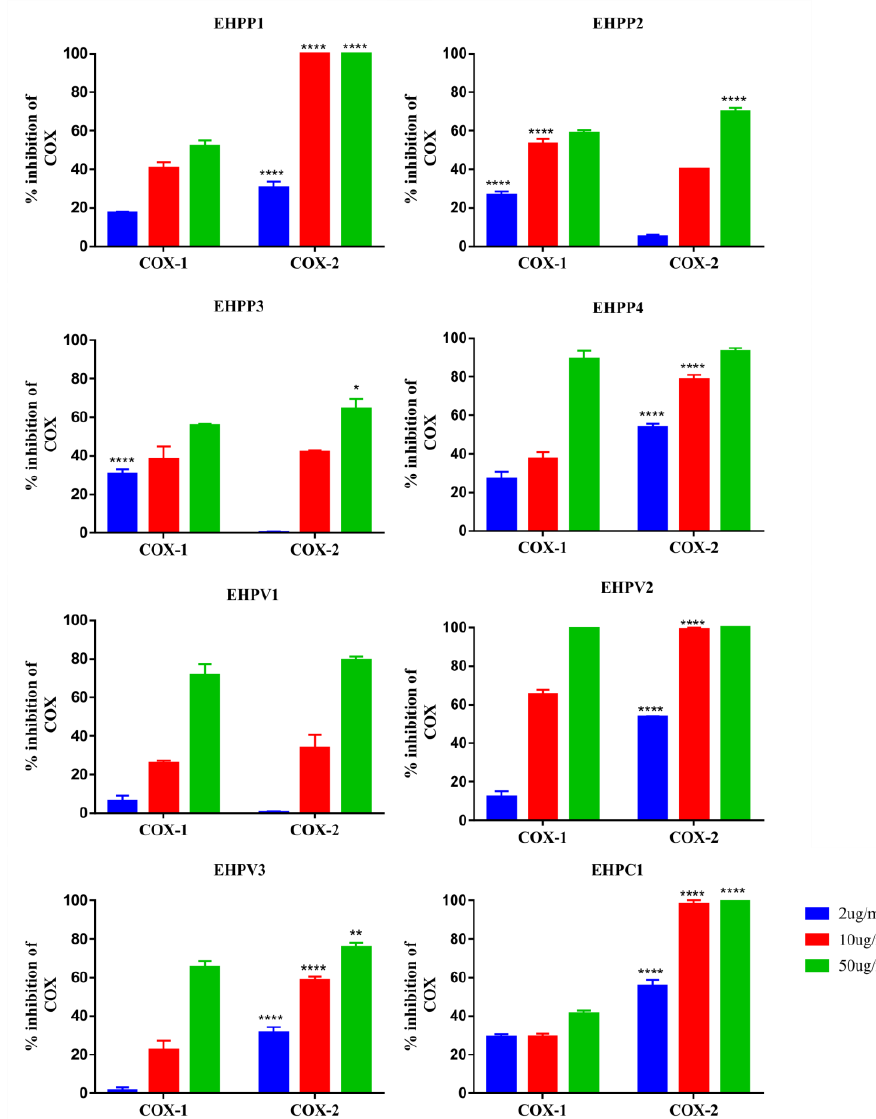
Figure 1. Percentage of in vitro inhibition of COX-1 and 2 produced by hydroethanolic pollen extract collected by M. fasciculata was obtained in Chapadinha (EHPC), Palmeirândia (EHPP1-4) and Viana (EHPV1-3) municipalities. Tested at three concentrations: 2 μg/mL, 10 μg/mL and 50 μg/mL. * Represents significant differences, * with p < 0.05; ** with p < 0.005; **** with p < 0.0001 comparing inhibition of cyclooxygenase 1 (COX-1) with 2 (COX-2). (Two-way ANOVA; Sidak).